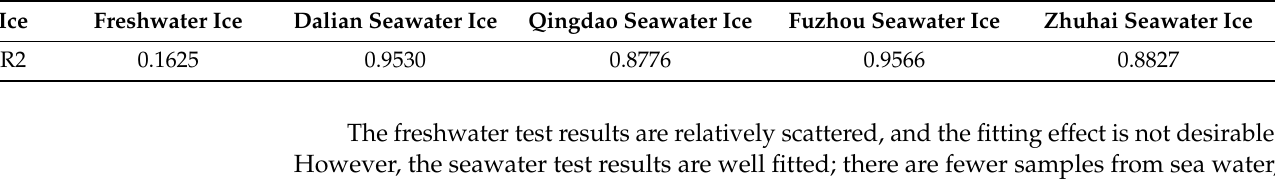
Table 3. The goodness of fitting curve of the shear strength test. (The closer the value in the table is to 1, the better the corresponding fitting effect. The seawater test results are well fitted while the freshwater test results are